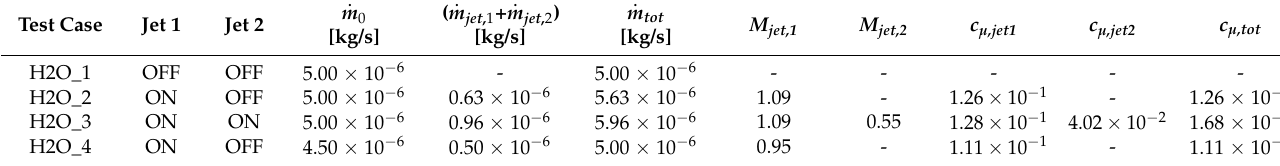
Table 5. Test matrix and micro-jet blowing conditions: water vapor flow. Jet temperature T jet1 = T jet2 = 505.58 K. Test Case Jet 1